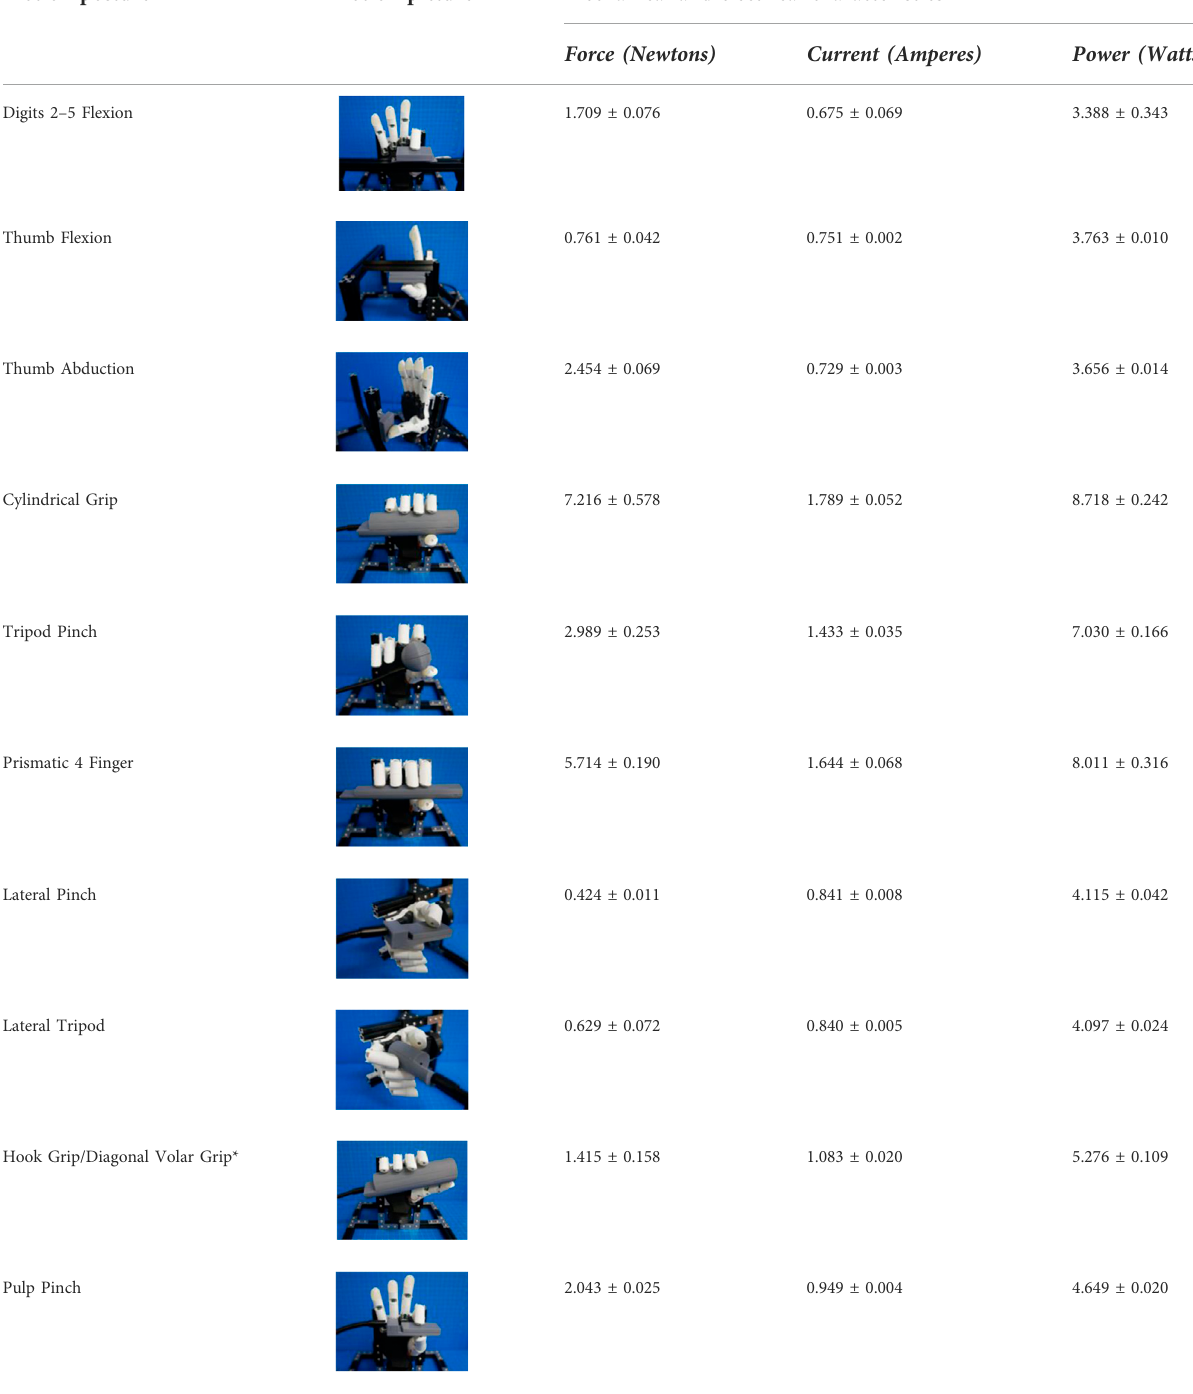
TABLE 5 BEAR PAW ’ s mechanical and electrical characteristics for the six degrees of actuation and the top seven generalized hand grasp con fi gurations.*HookGripandDiagonalVolarGriphavethesamegrosshandmotion,yetintheAHAPtesttheseareconsideredseparatemotions which include a different set of